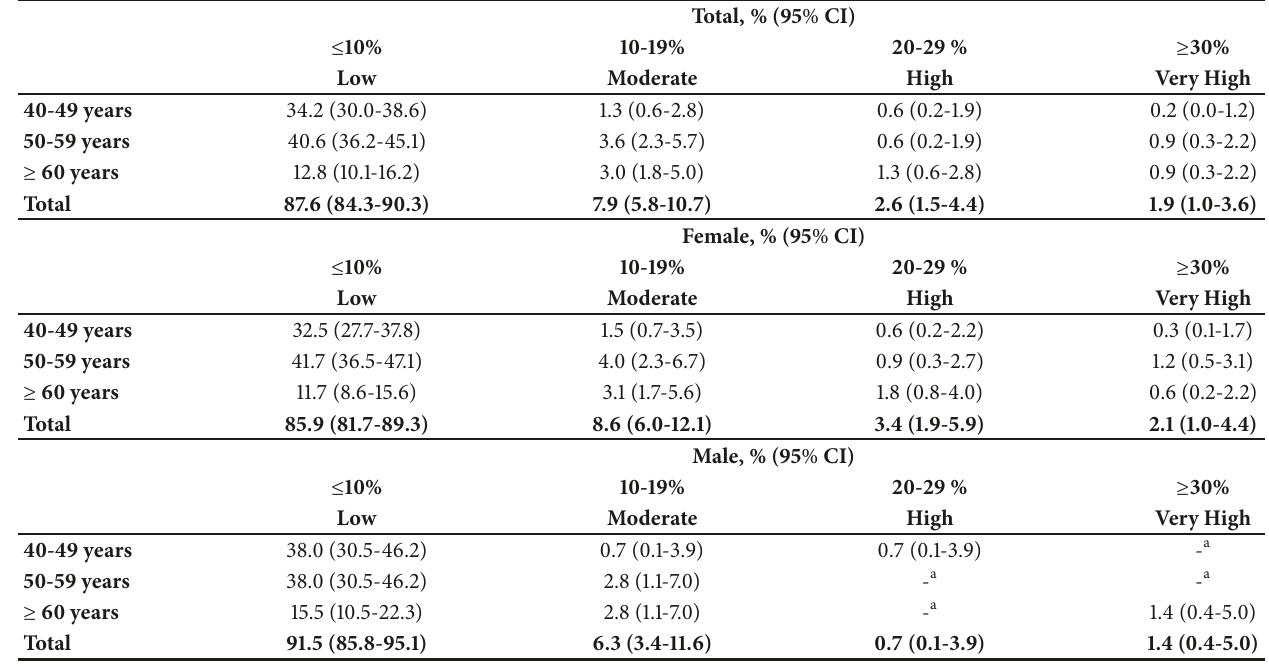
Table 2: Distribution of 10-year risk of a fatal or nonfatal major cardiovascular event, according to sex and age.